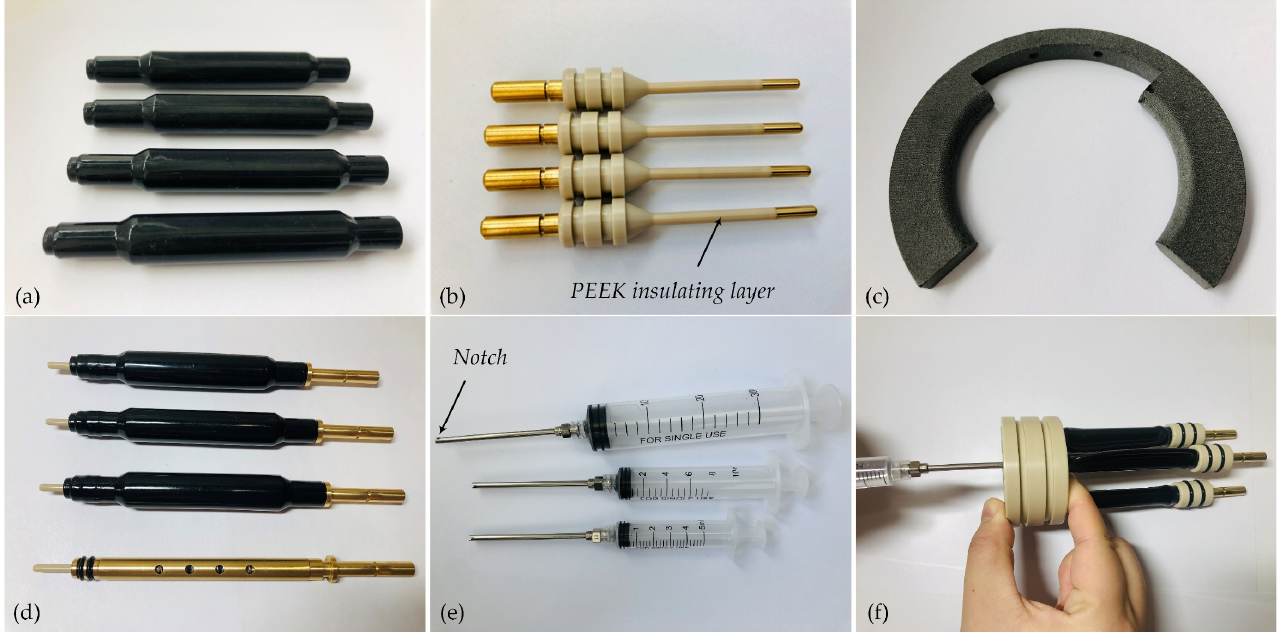
Figure 15. The core components in the prototyping of the proposed wet-mateable electrical connector: ( a ) secondary resilient bladders, ( b ) contact pins with PEEK insulating layers, ( c ) latching member, ( d ) assemblies of electric contact, ( e ) oil-filling syringe, ( f ) process of oil-filling.